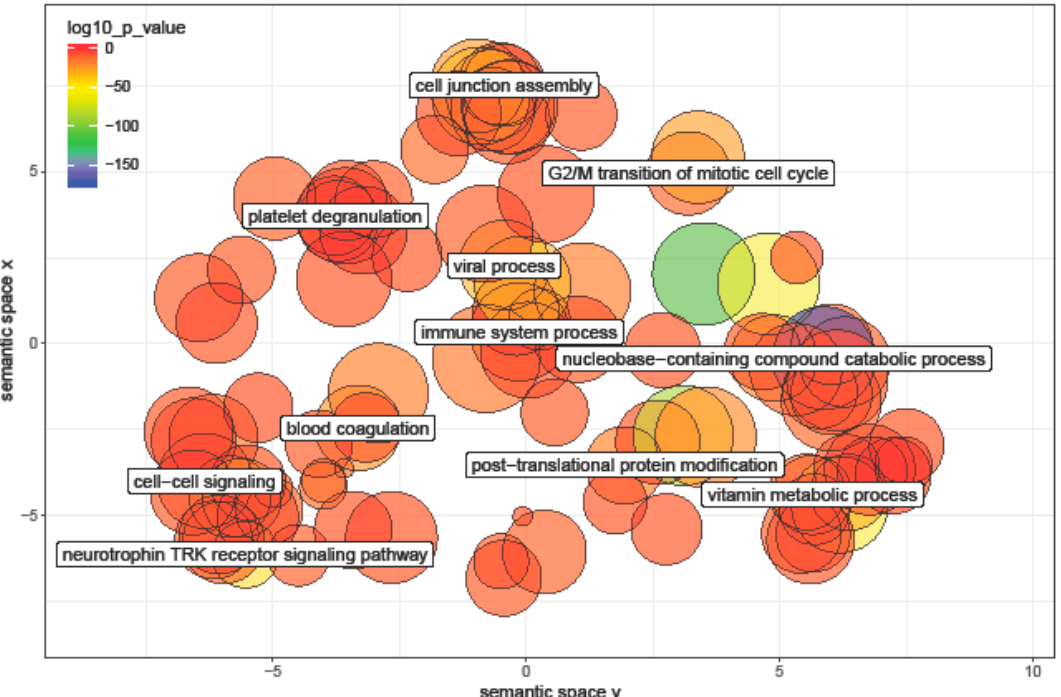
Figure 5. Enriched gene ontology (GO) terms: miRpath v3.0 was used to identify significantly enriched GO terms among predicted mRNA targets of 36 miRNAs that were differentially expressed between newborns and 7-year-old children. The miRNA-related GO terms related to age differences in children fell into several broad categories including immune system process, neurotrophin tropomyosin-related kinase (TRK) receptor signaling, post-translational protein modification, and mitotic cell cycle.